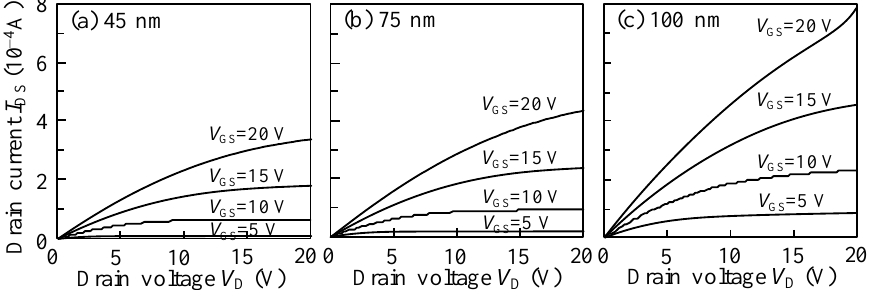
Figure 3. Output characteristics of TFT devices with various T ITZO of ( a ) 45, ( b ) 75, and ( c ) 100 nm.